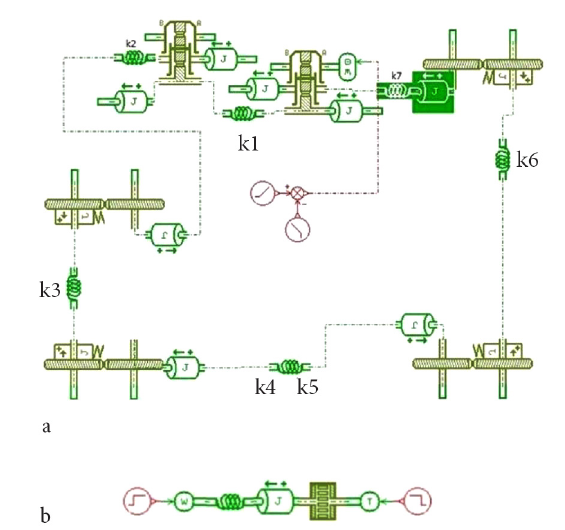
Fig. 11. Modelling results: a) simulated model of the system in AMESIM; b) simplified open-loop model of the system in AMESIM